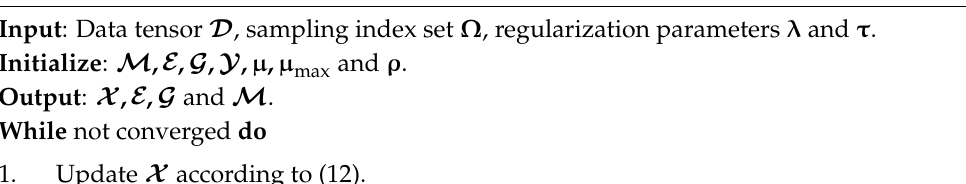
Algorithm 1 . Solving GLRTR by